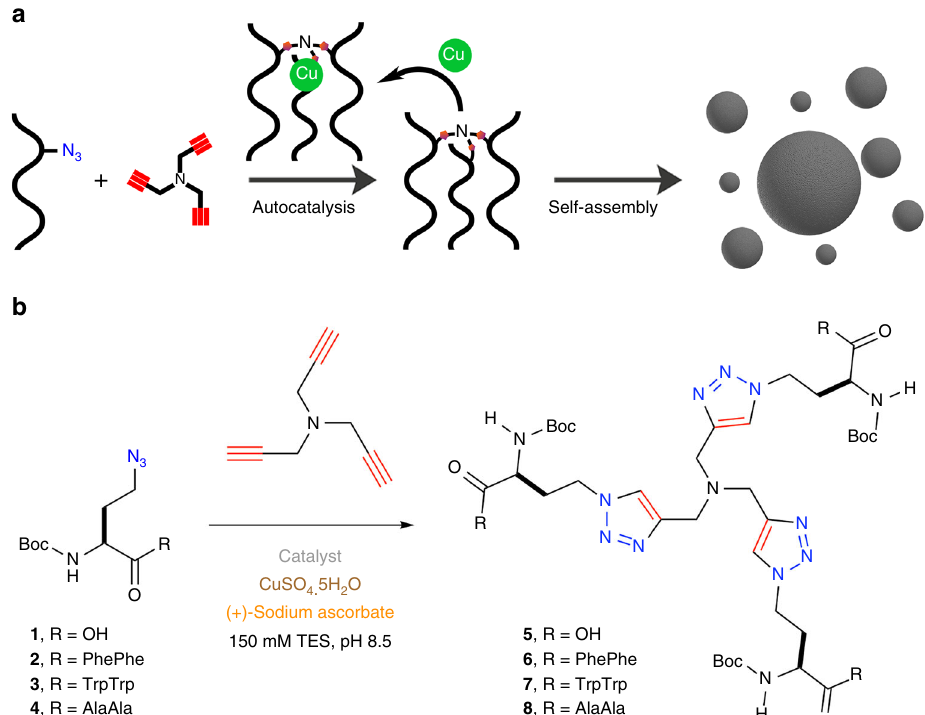
Fig. 1 Self-assembling autocatalysts. a Copper-dependent autocatalytic oligotriazole formation leads to continuous generation of triskelion peptides, which spontaneously assemble into nanospheres. b Synthesis of tris(triazole) tripodal peptides by conjugation of a tripropargylamine scaffold with azide-modi fi ed